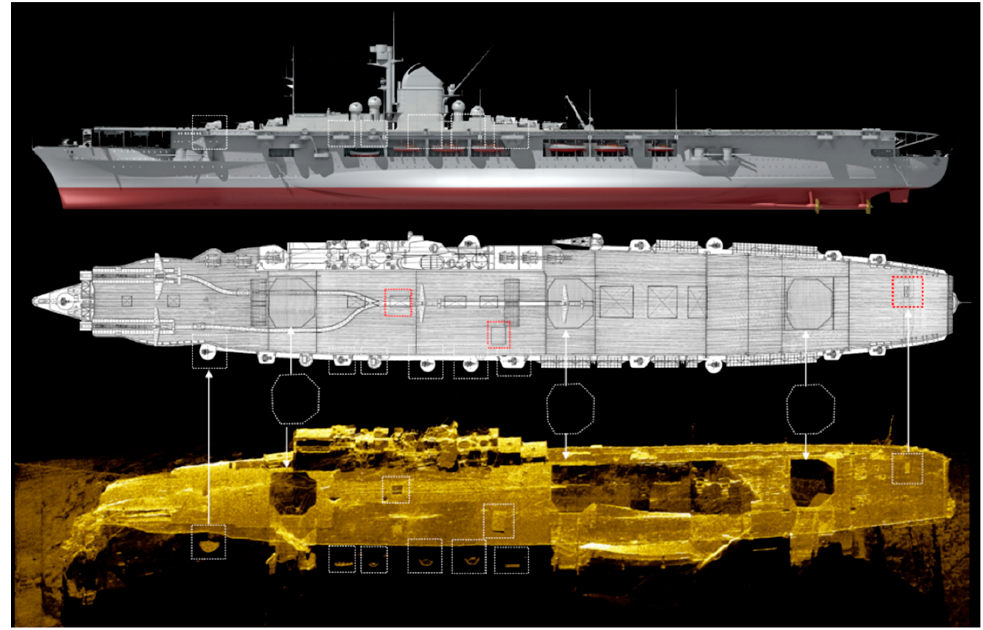
Figure 22. A comparative analysis of sonar data with the appearance of the ship. Top view and port view of the aircraft carrier Graf Zeppelin [27].